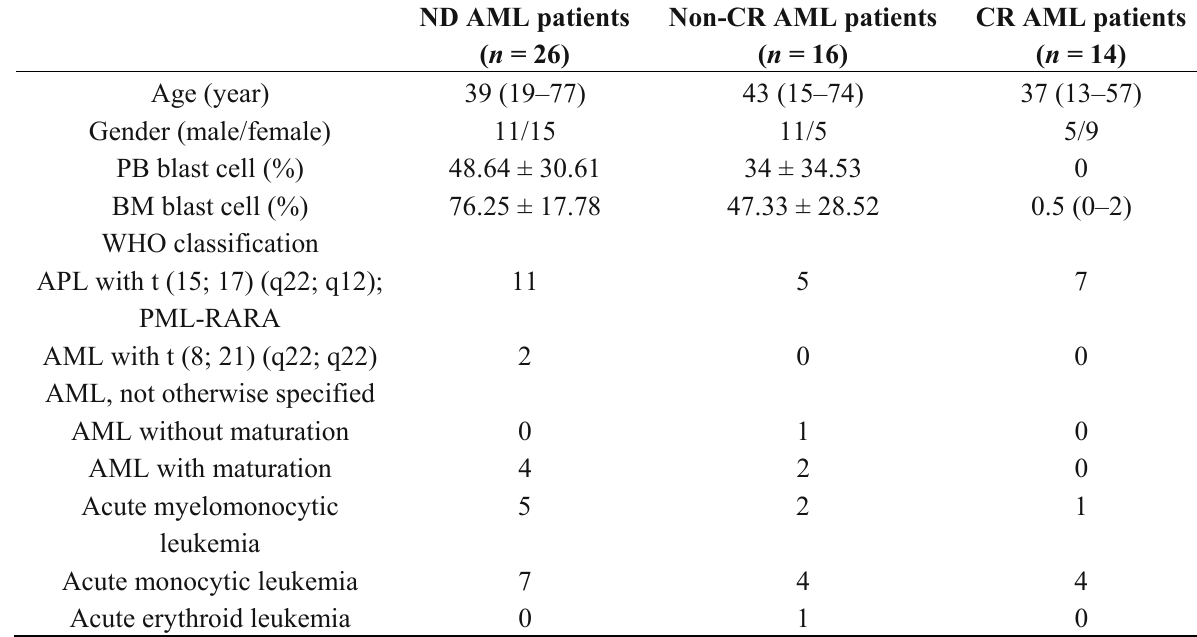
Table 1. Clinical features for acute myeloid leukemia (AML) patients.